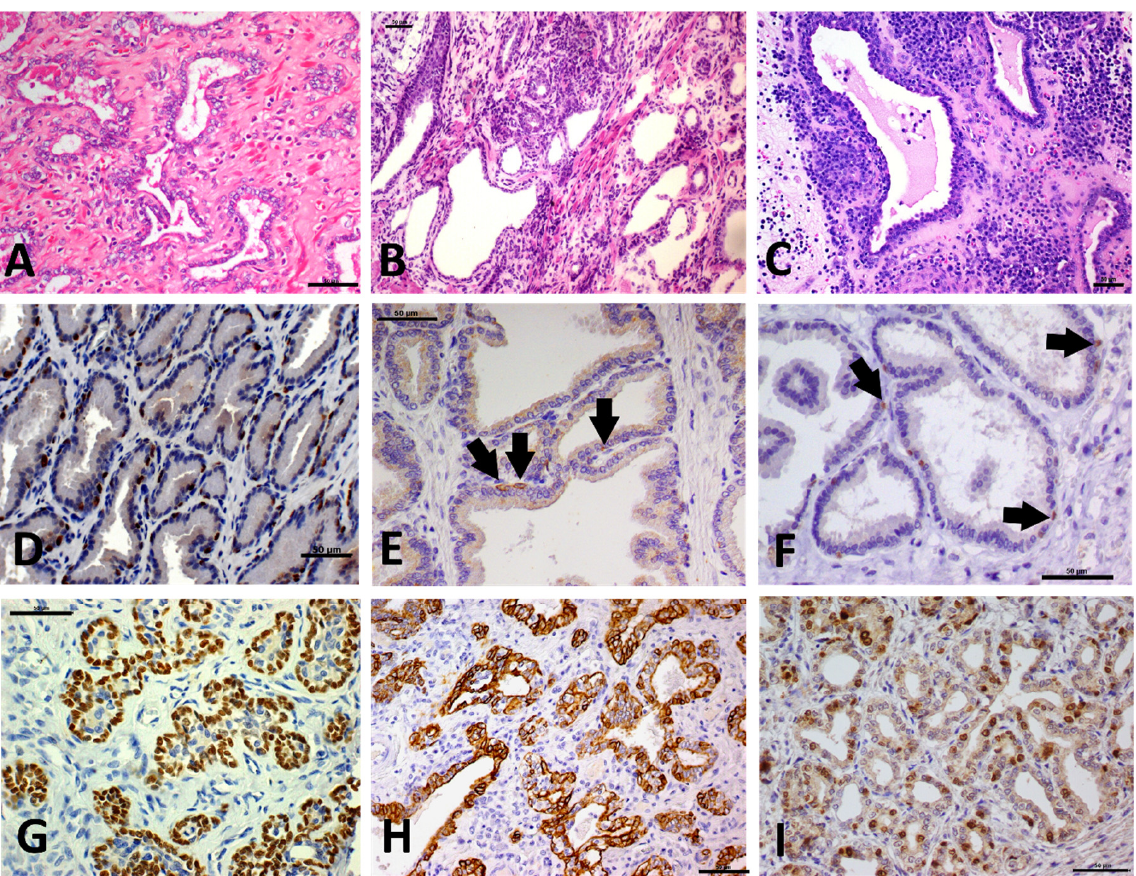
Figure 1. Hematoxylin and eosin (H&E) staining and immunohistochemistry of canine prostate with proliferative inflammatory atrophy (PIA). ( A ): Discrete mononuclear inflammatory infiltrate admixed with multifocal atrophic glands with at least two layers of epithelial cells. ( B ): Moderate mononuclear inflammatory infiltrate and areas of prostatic gland atrophy with cells showing hyperchromatic nuclei and at least two layers of epithelial cells. ( C ): Severe mononuclear inflammatory infiltrate with atrophic epithelial cells showing at least two layers of epithelial cells, hyperchromatic nuclei and evident nucleolus. ( D ): Nuclear p63 expression in a normal prostate gland. There is a discontinuous basal cell layer. ( E ): High molecular wight cytokeratin expression by normal basal cells (arrows). ( F ): Nuclear Ki67 expression by normal basal cells (arrows). There is an absence of Ki67 in luminal epithelial cells and only scatted basal cells express Ki67. ( G ): Diffuse P63 expression by atrophic cells in a PIA. ( H ): Diffuse membranous expression of high molecular weight cytokeratin in a PIA. ( I ): Nuclear positive Ki67 expression by atrophic cells in a PIA lesion. Scale bar = 50 μ m.